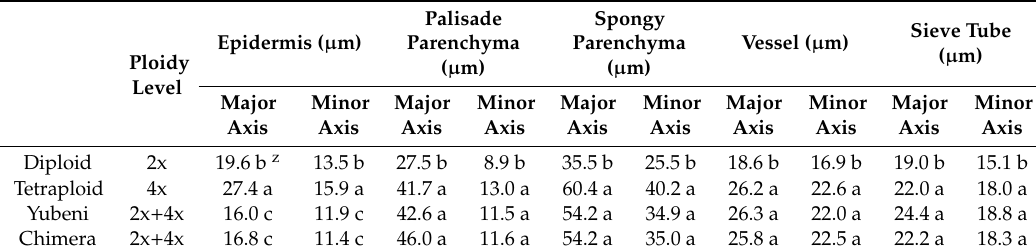
Table 3. Comparison of the cell sizes of leaves in the diploid, the tetraploid, the Yubeni, and the chimera of the Meiwa kumquat.